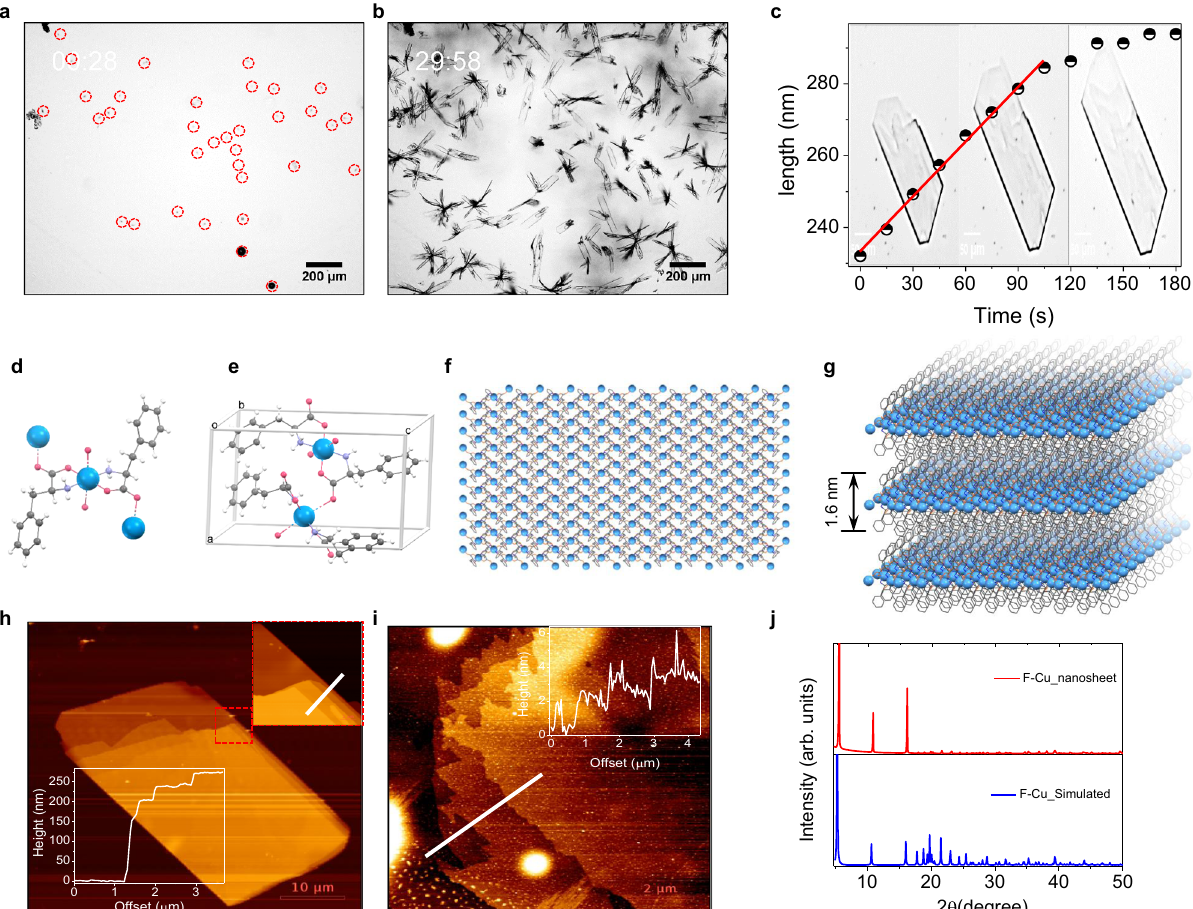
Fig. 2 Structural characterization of F-Cu. a , b Optical microscopy snapshots taken from the in situ real-time monitoring of the F-Cu crystallization process (Supplementary Movie 1), showing the formation of a small nucleation seeds (red dotted circles) at 28 s and b grown micrometer-long 2D crystals at ~30 min. Each experiment was repeated three times independently with similar results. c Optical microscopy snapshots are taken from Supplementary Movie 2, which monitors the in situ crystallization kinetics of the F-Cu 2D layered crystals and corresponding graphical representations of the elongation rate. The calculated average measured elongation rate is 7.89 nm s − 1 . d – g Single-crystal X-ray structure of F-Cu ( d ), F-Cu assembly exhibits an octahedral primary coordination complex structure ( e ). The unit cell is comprised of four F molecules and two Cu 2 + ions ( f ), 2D in fi nite layered F-Cu coordination complex structure shown along the crystallographic plane. g Hierarchical 2D van der Waals layered stacked structure shown along the crystallographic plane. h , i AFM images and height pro fi les of F-Cu 2D layered crystals h before and i after ultrasonication treatment, displaying the mechanical exfoliation of pristine 2D hierarchical layered F-Cu crystals into single or several-layered nanosheets. The AFM height pro fi les of nanosheets (~1.8 nm thick) are in good agreement with the single atomic layer thickness in the crystal structure (~1.6 nm thick, g ). j PXRD patterns simulated from F-Cu crystal structure and experimental 2D